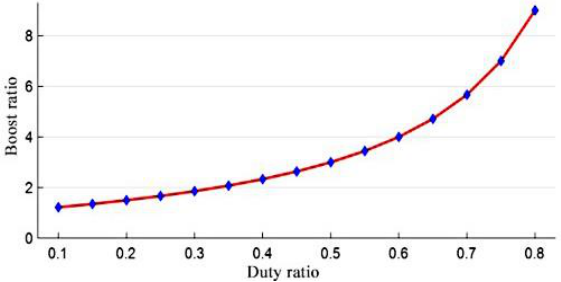
Figure 4. The relationship between voltage gain and duty cycle.